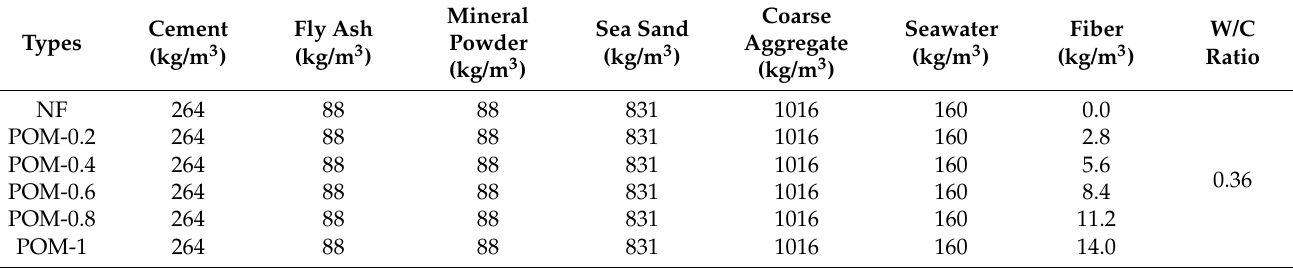
Table 4. Proportions of all SWSSC mixtures.